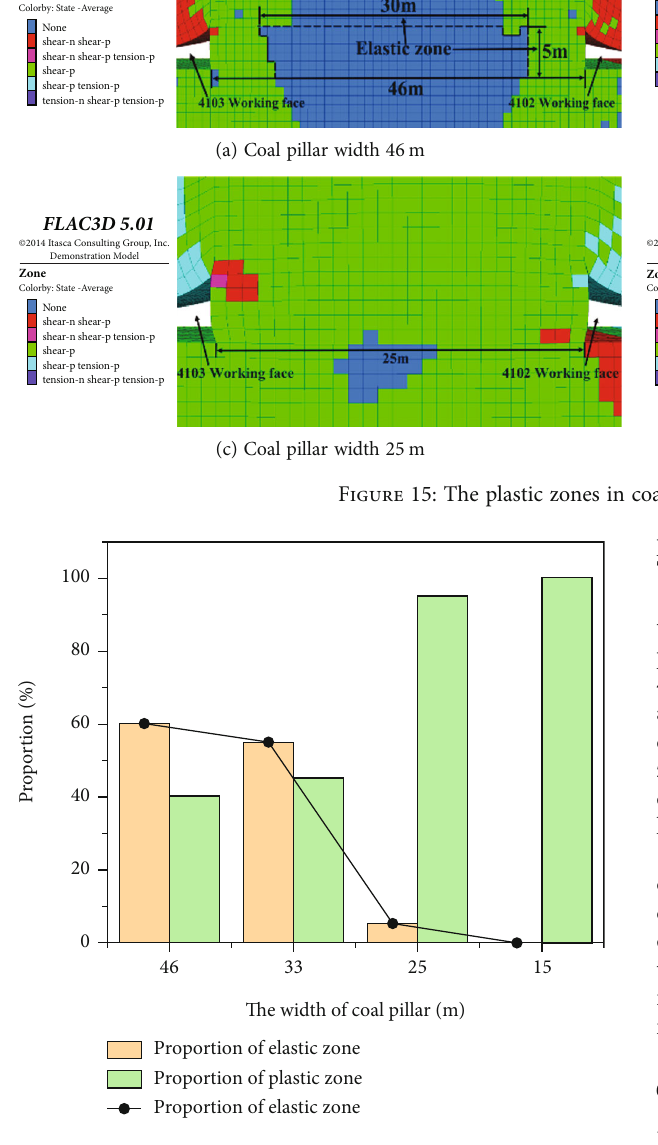
Figure 16: Variation curve of plastic zone in coal pillars with di ff erent